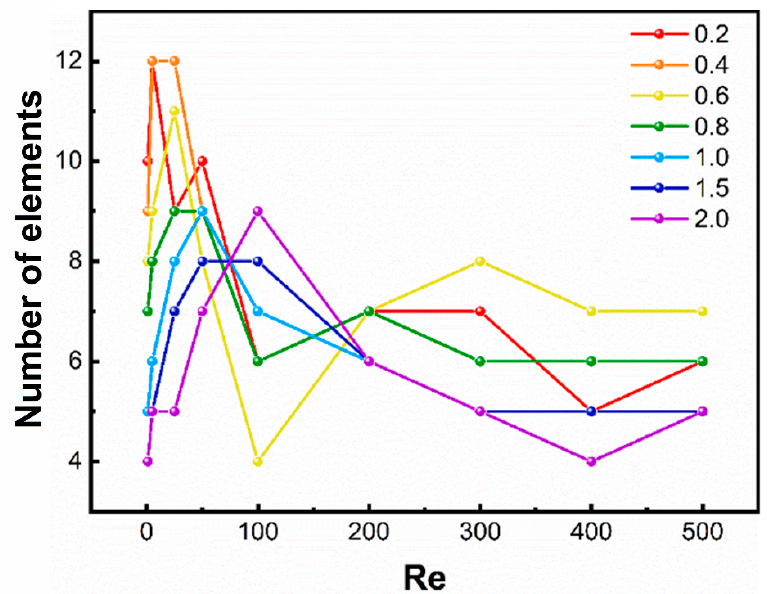
Figure 12. Effect of aspect ratio on number of elements at different Re.